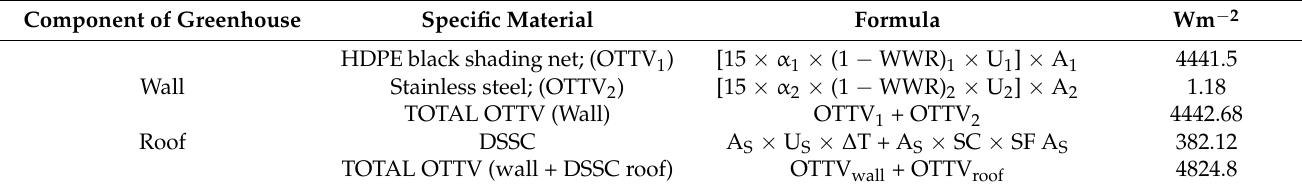
Table 2. The novelty of the Overall Thermal Transfer Value (OTTV) calculation for the DSSC mini greenhouse studied by Lu et al.